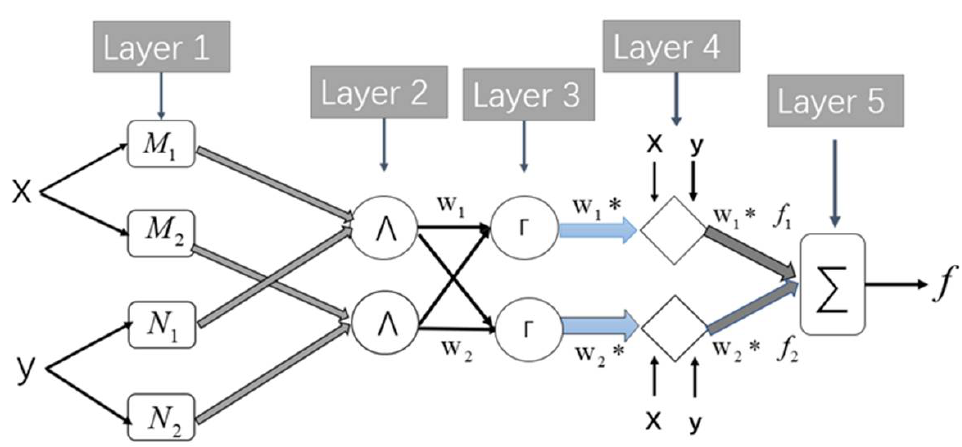
Figure 1. Schematic of an ANFIS structure.